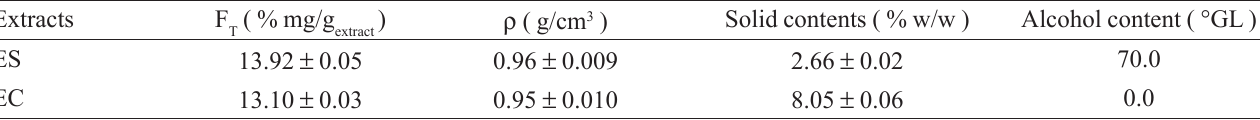
TABLE II - Properties of the extractive solution and of the concentrated extract